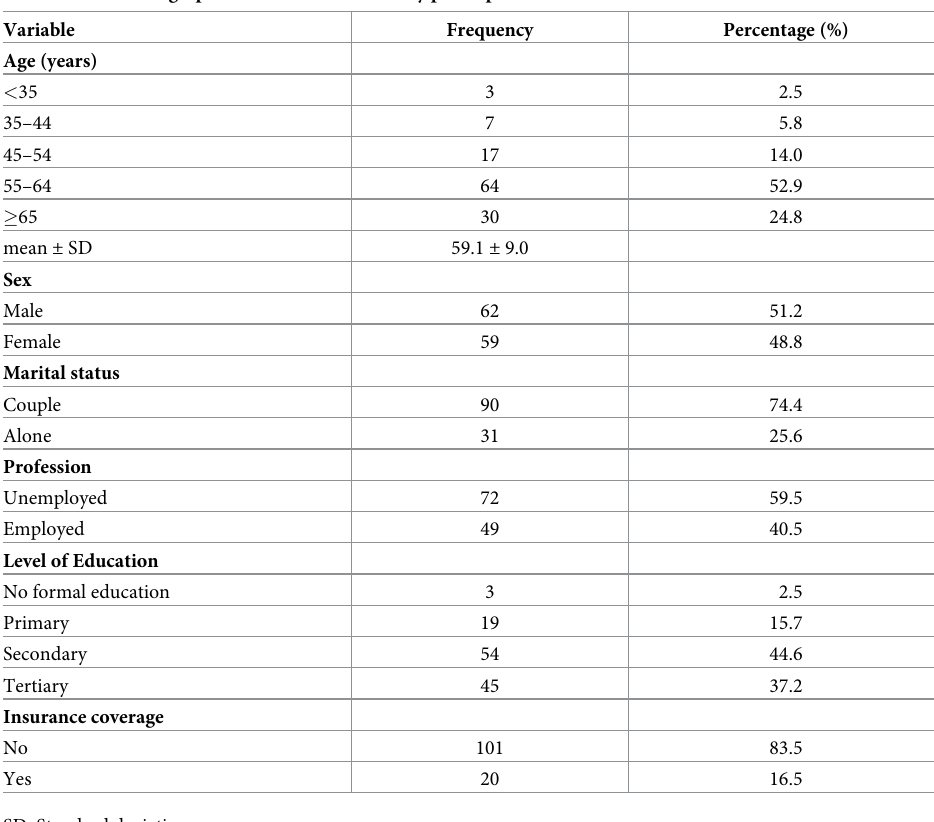
Table 1. Sociodemographic characteristics of study